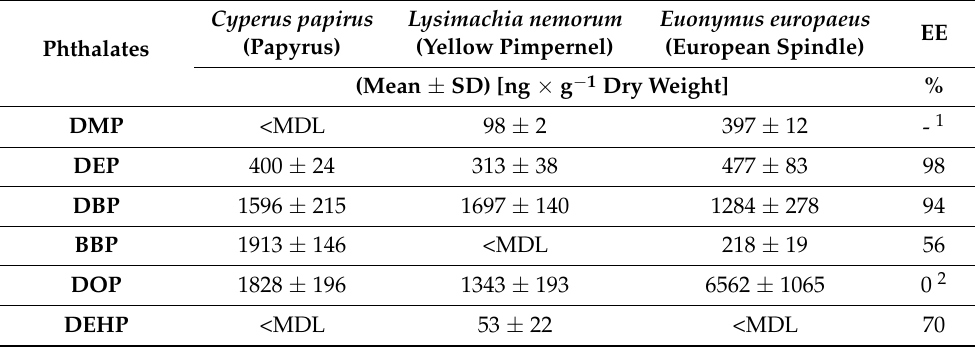
Table 5. Results of the determined target compounds in three species of hydroponically cultivated plants from an MWWTP using the developed UAE–SPE–GC–MS(SIM) method (n = 3), and the elimination efficiency of these compounds from wastewater in an MWWTP supported by